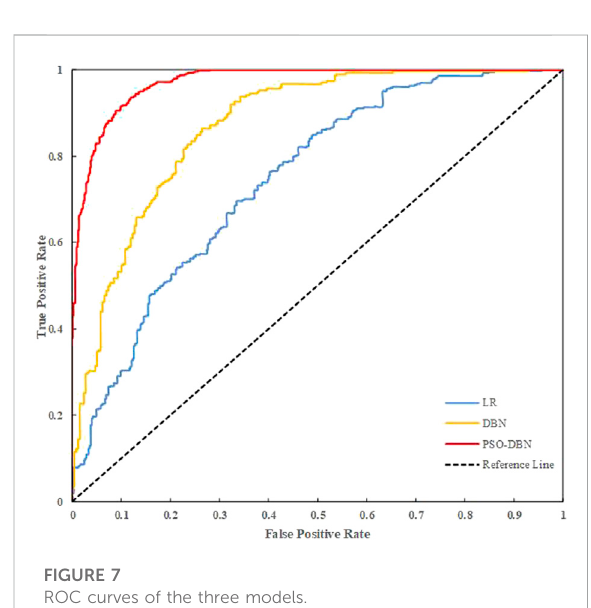
Table 3 (note: in the column ‘ hyperparameter combinations ’ , the items from left to right are the batch size, learning rate of neurons in the BP layer, learning rate of neurons in the RBM layer, epoch number of the RBM layer, and epoch number of the BP layer).